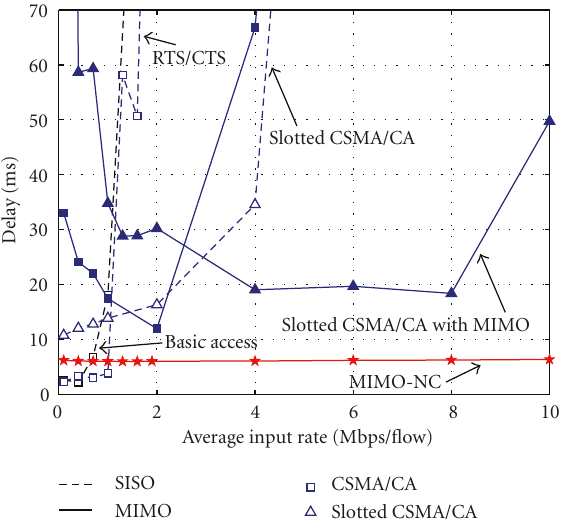
Figure 16: Average packet delay performance comparison of CSMA/CA and MIMO network coding (light tra ffi c).